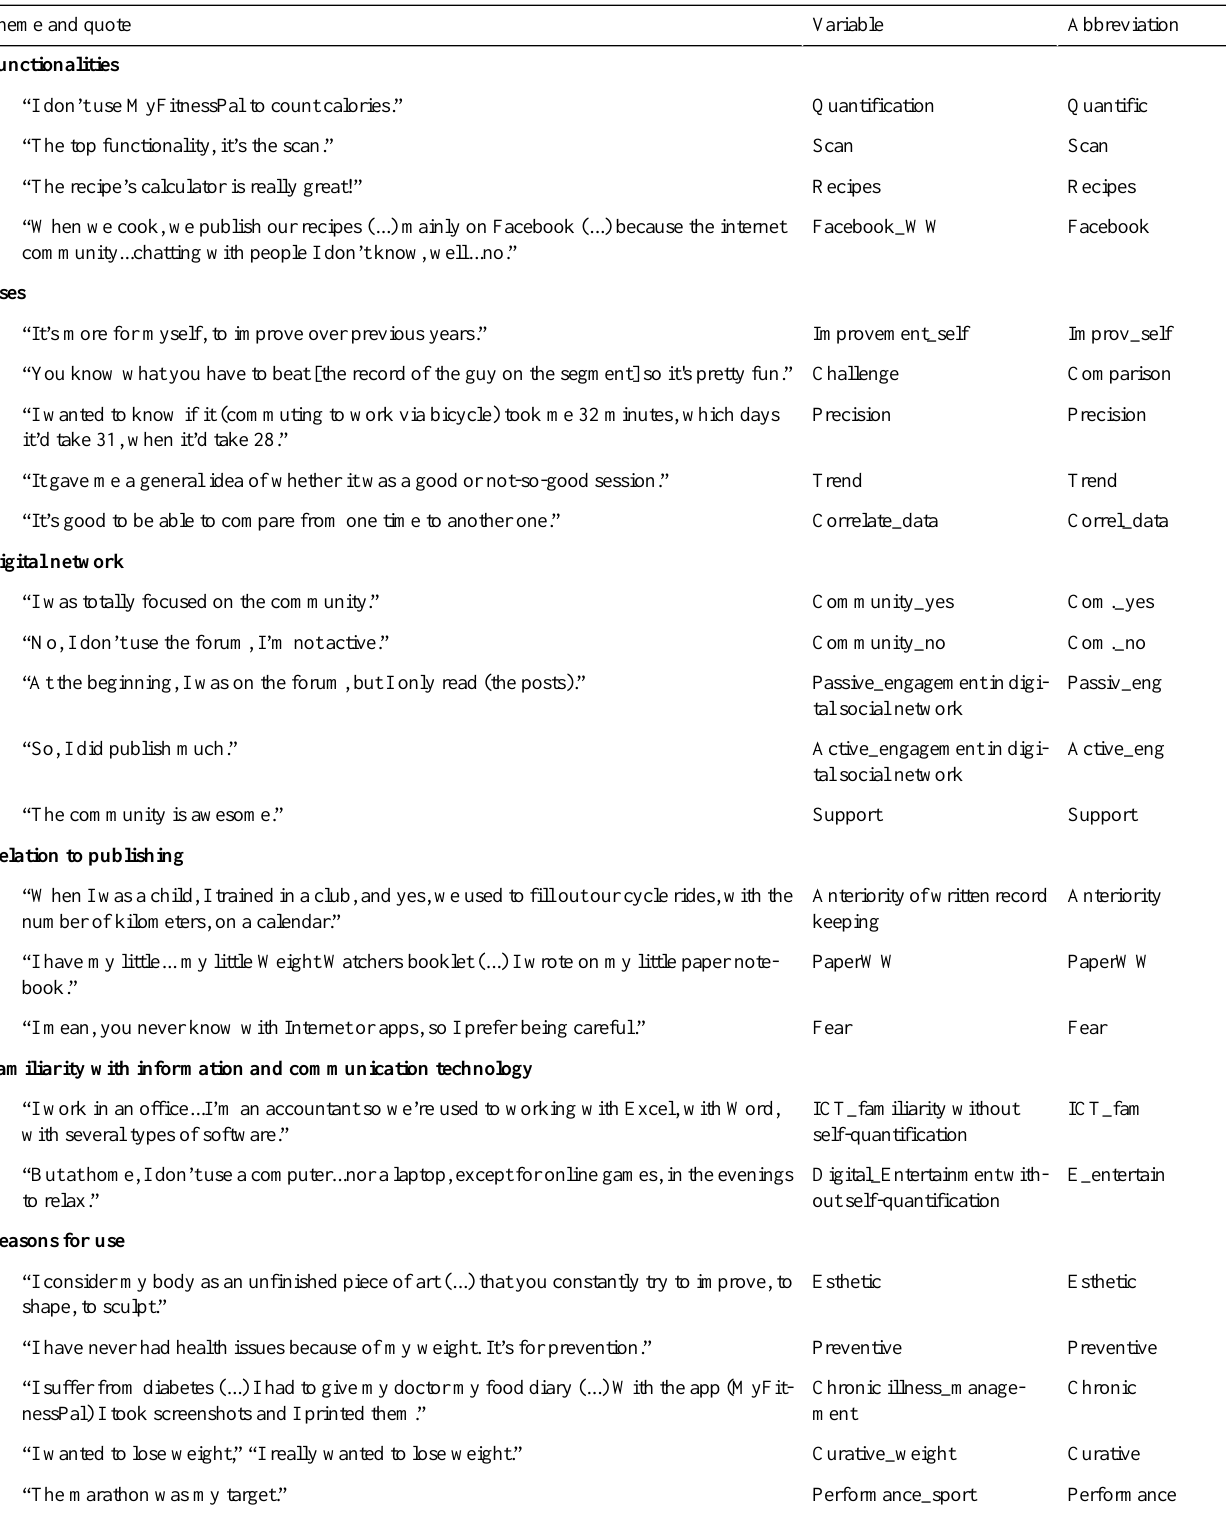
Table 1. Twenty-five variables determined by different uses, categorized by theme and examples of quotes. ICT: information and communication technology; WW: Weight